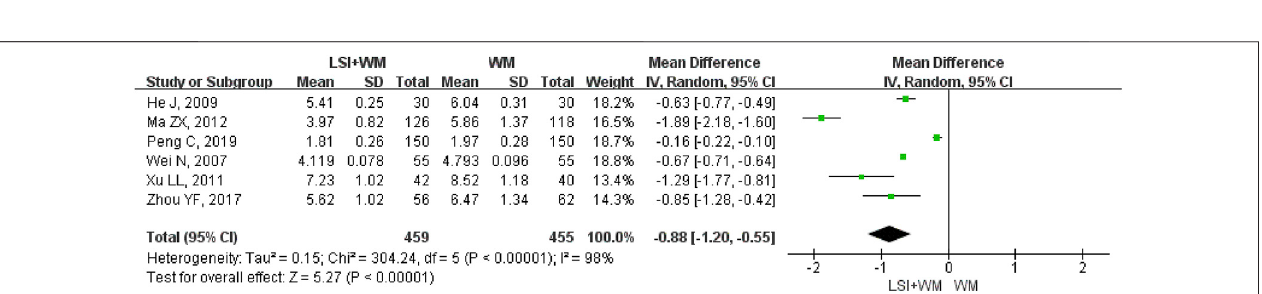
FIGURE 7 | Forest plot of HBV of ligustrazine injection in treating ACI. LSI is ligustrazine injection and WM is Western medicine.